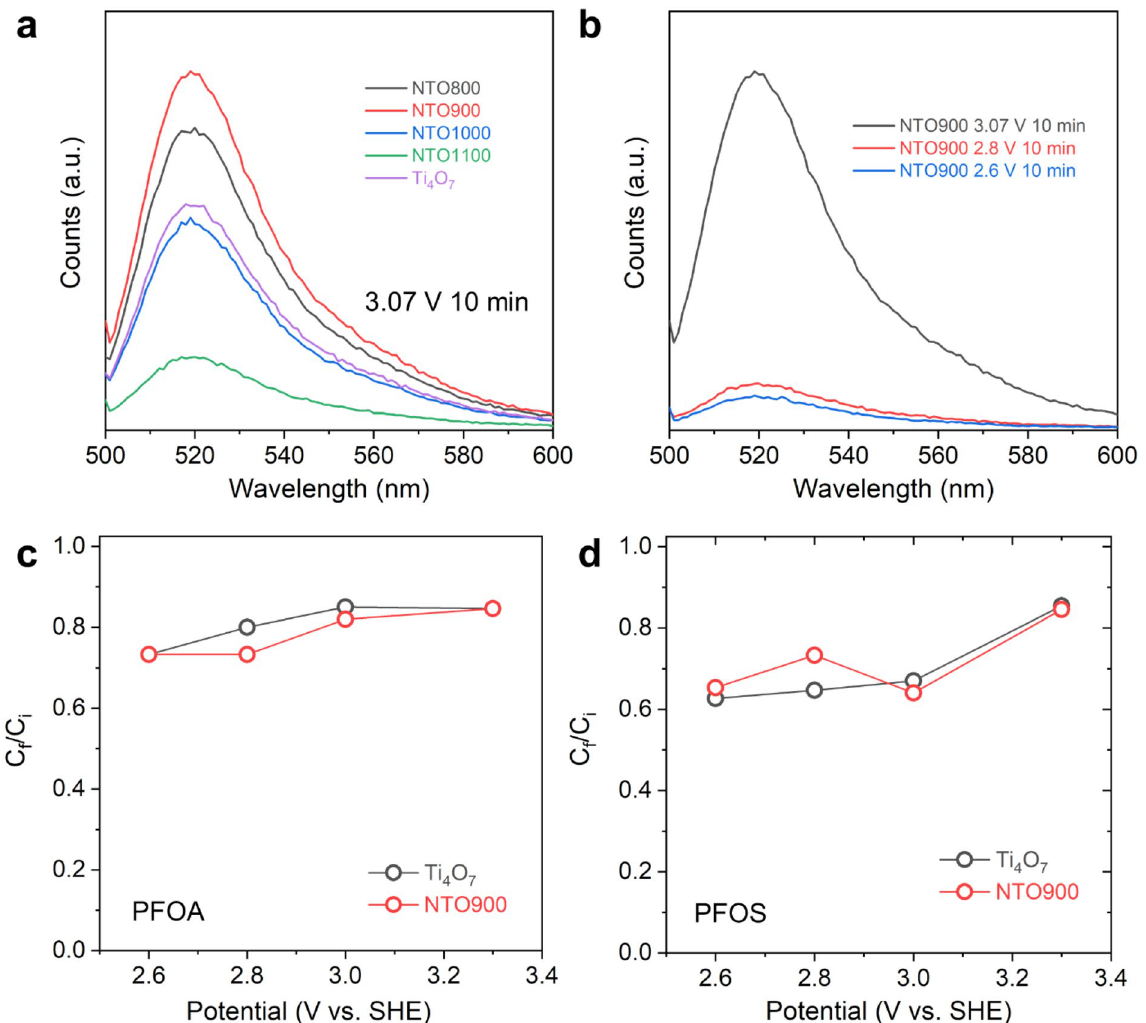
Figure 6. Fluorescence data using 2’–7’-dichlorofluorescin diacetate (DCFH-DA) by performing chronoamperometry at ( a ) 3.07 V vs. SHE for 10 min for NTO800, NTO900, NTO1000, NTO1100, and Ti 4 O 7 ; and ( b ) 2.6, 2.8, and 3.07 V vs. SHE for 10 min of NTO900 to verify generation of reactive oxygen species. Practical electrochemical oxidation treatment of 20 ppb for 30 min of ( c ) perfluorooctanoic acid (PFOA) and ( d ) perfluorooctanesulfonic acid (PFOS) in de-ionized water for Ti 4 O 7 and NTO900. C f /C i is the ratio between the final and initial concentrations of the organic contaminants. Standard error for these treatments were within 5% based on replicate